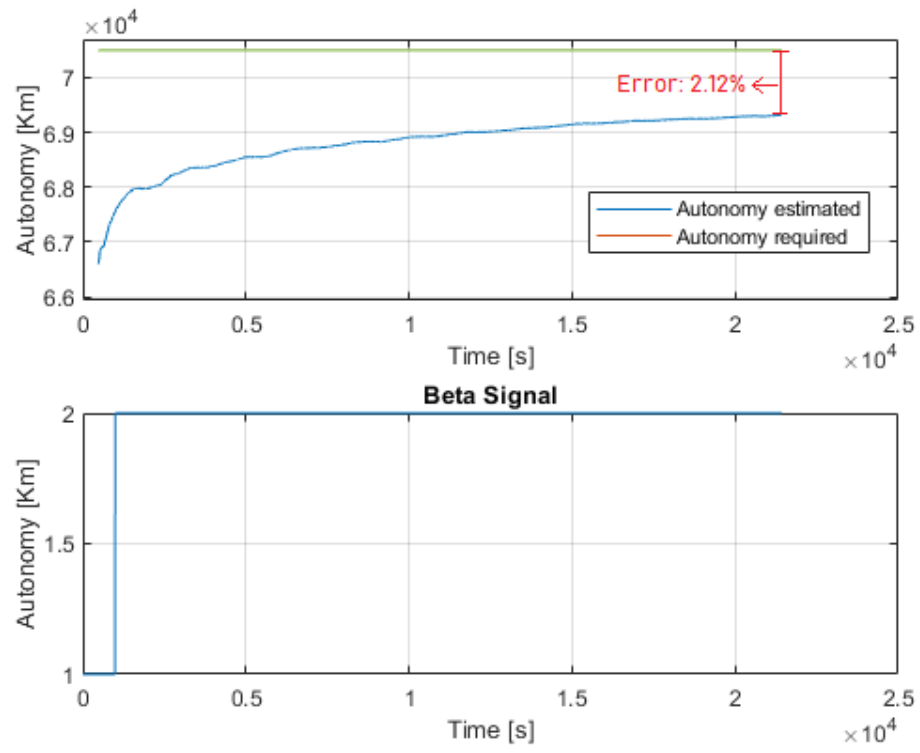
Figure 29. Bad speed profile